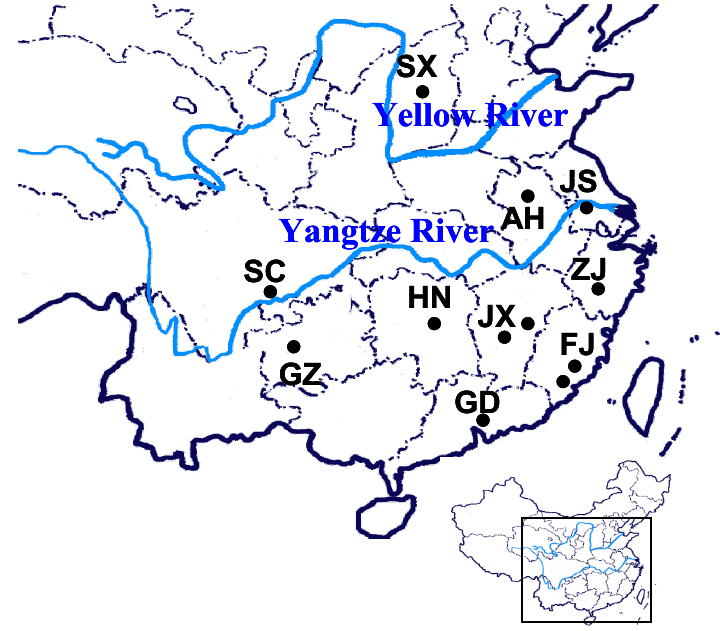
Figure 1. The localities of the samples of G. jasminoides Ellis var. grandiflora Nakai and G. jasminoides from different regions in China. The spots in dark blue indicate the localities where the samples were collected, the lines in light blue indicate the Yangtze River and Yellow River.